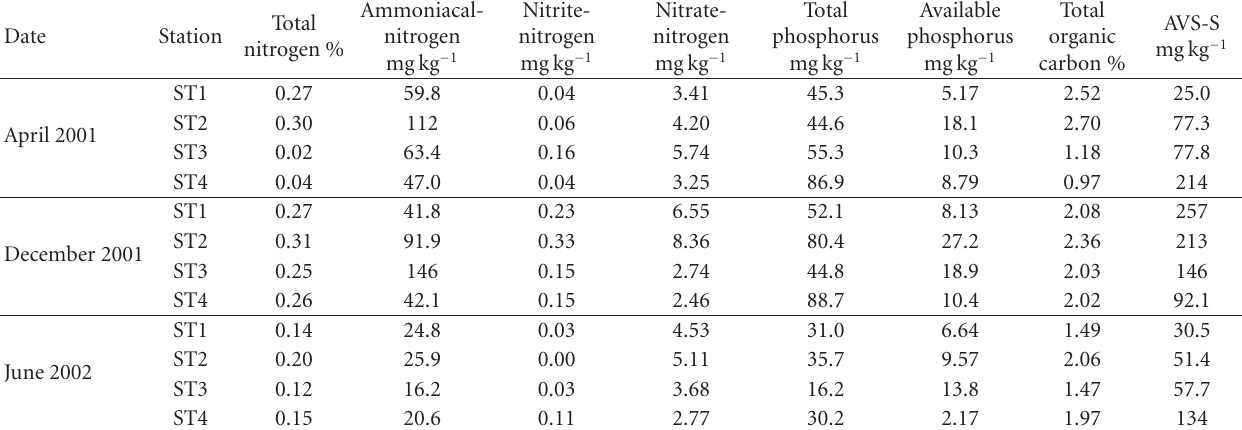
Table 2: Results of sediment analyses conducted in April 2001, December 2001, and June